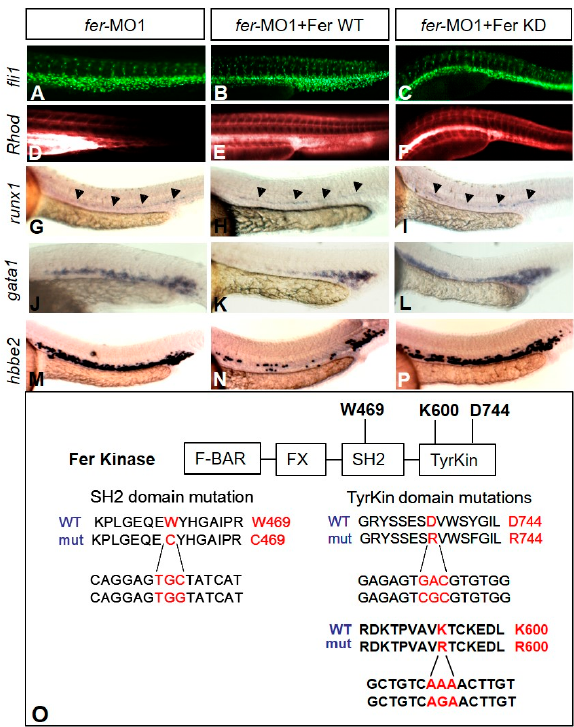
Figure 7. Kinase-inactive Fer rescues vascular tubulogenesis but not hematopoiesis gene expression defects. The injection of fer mRNA and fer -MO1 into fli1a::nEGFP embryos results in increased cell migration into the ISV regions (( B )—WT, ( C )—kinase inactive (KD)) when compared to fer -MO1 alone ( A ), and rescues tube formation (( E )—WT, ( F )—KD, Rhodamine-Dextran circulation after 15 min, when compared to fer -MO1 alone ( D )). Wild type Fer ameliorates defects in erythrocyte expansion, as observed with runx1 ( H ), gata1 ( K ) and hbbe2 ( N ), while inactive Fer does not (( I , L , P ) respectively). fer -MO1 alone is shown in ( G , J , M ) respectively. Embryos were examined at 30 somites (~28 hpf). Domains of Fer kinase in zebrafish, showing the highly conserved tryptophan and aspartic acid residues, in the SH2 and tyrosine kinase domains, respectively, are shown. Mutating either tryptophan to cysteine (W469C), aspartic acid to arginine (D744R) or lysine to arginine (K600R) resulted in the loss of kinase activity for Fer. The amino acid sequence is shown on top, with the corresponding DNA sequence changes below (( O ), Fer KD expression confirmation shown in Supplementary Figure S1).